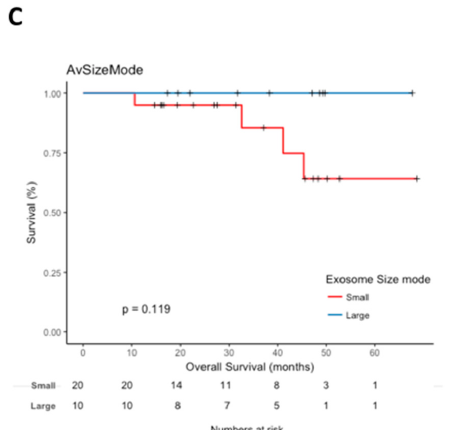
Figure 4. ( A ) ROC curve analysis of pulmonary vein exosomal size values predicting relapse after surgery in stage I NSCLC patients. The cut-off for relapse was set at 112.3 nm. The area under the curve of 0.76 with pulmonary vein exosomal size values of <112.3 nm resulted in a sensitivity of 80% and specificity of 72%. ( B ) Kaplan-Meier survival analysis of associations between pulmonary vein exosomal size and time to relapse (TTR) among patients with stage I NSCLC. ( C ) Kaplan-Meier survival analysis of the association between pulmonary vein exosomal size and overall survival (OS) among patients with stage I NSCLC.